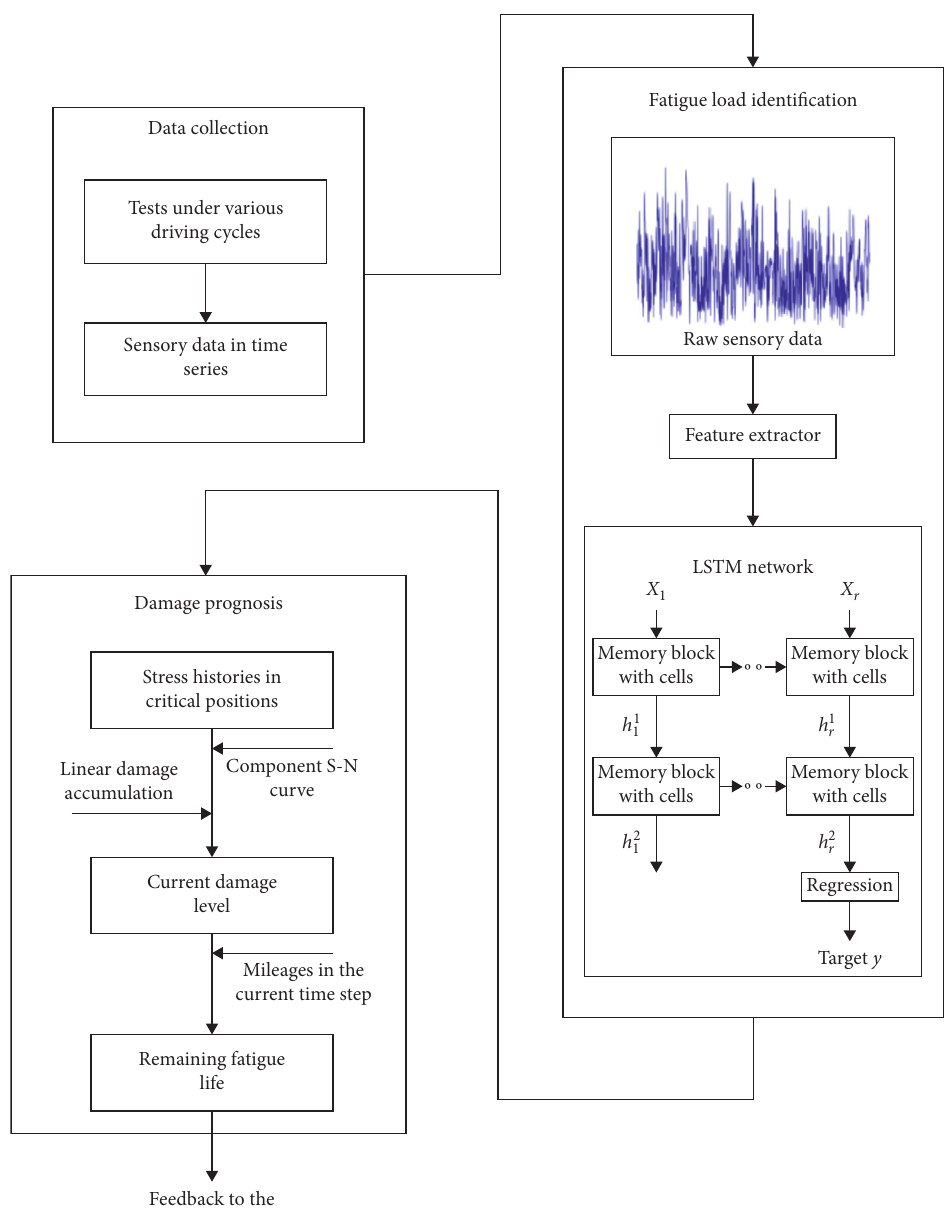
Figure 1: Adopted flowchart to develop a structural health monitoring